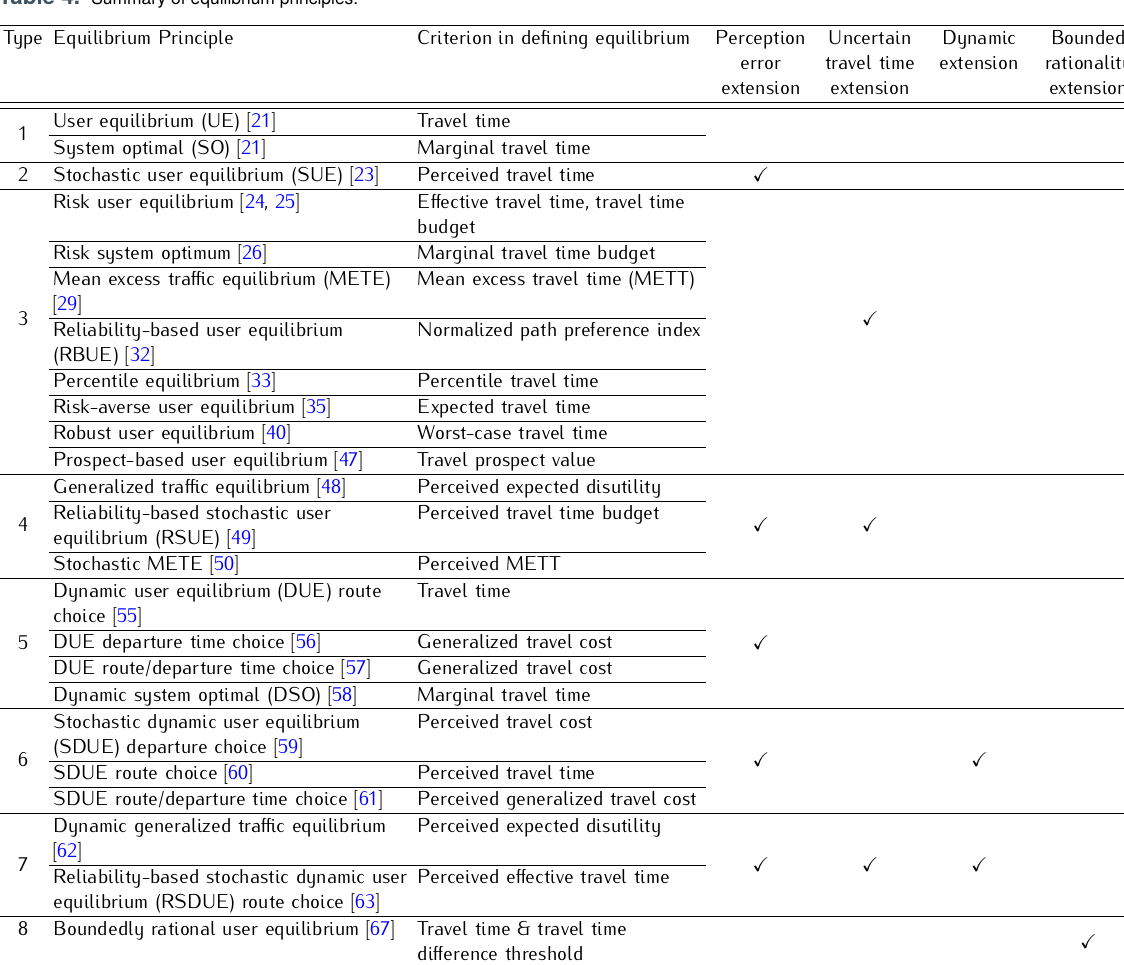
Table 4. Summary of equilibrium